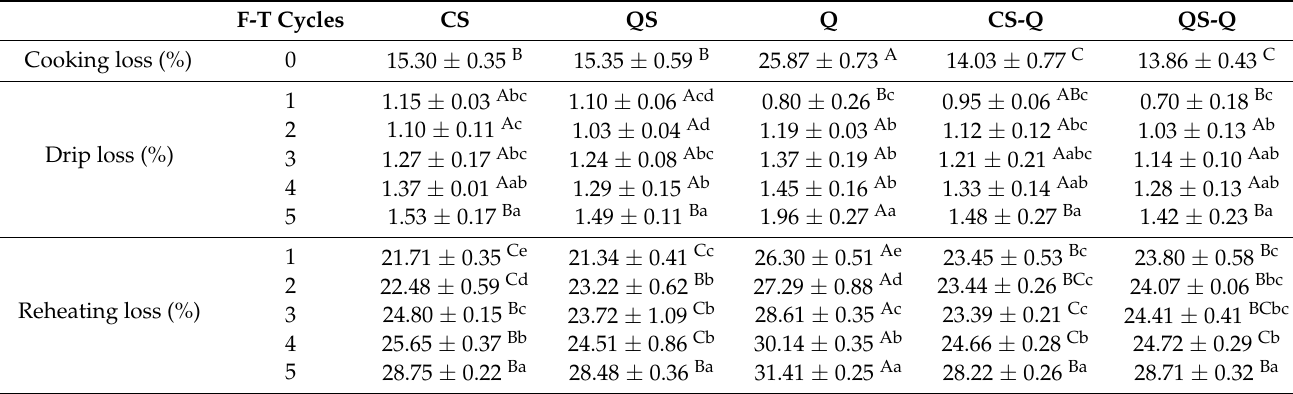
Table 2. Cooking loss, drip loss, and reheating loss of chicken meatballs during five freeze-thaw cycles (F-T cycles). F-T Cycles